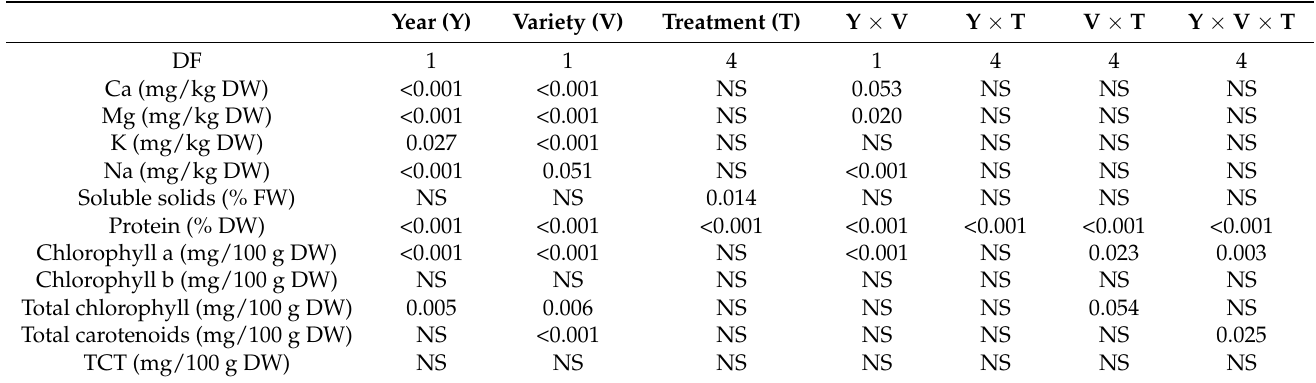
Table 1. Combined analysis of variance for the effects of year, variety and treatment on seed Ca, Mg, K, Na, soluble solid, protein, chlorophyll a, chlorophyll b, total chlorophyll, total condensed tannin and total carotenoid